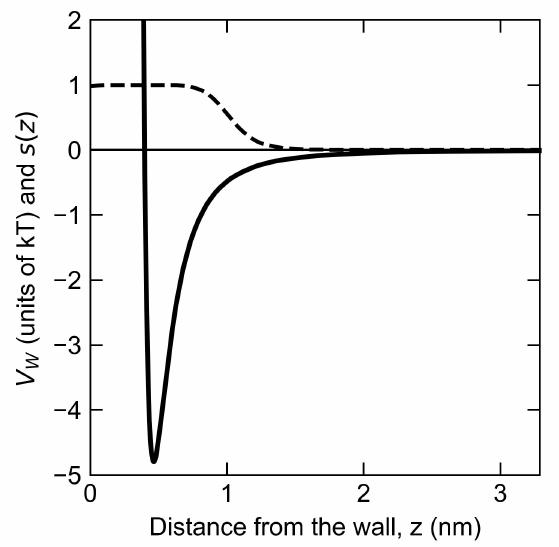
Figure 3. Switching function s ( z ) (dashed line) given by Equation (13) that weights the degree to which a monomer counts as “adsorbed,” thereby adding to contact number. Monomer-wall potential (thick solid line) V W given by Equation (15) for ε P W = 1 k B T. Zero potential is plotted as the thin, horizontal